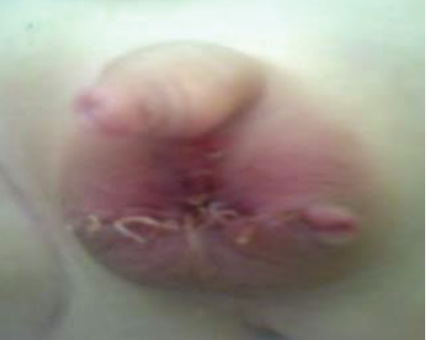
Figure 4: Postoperative view of the scrotum.